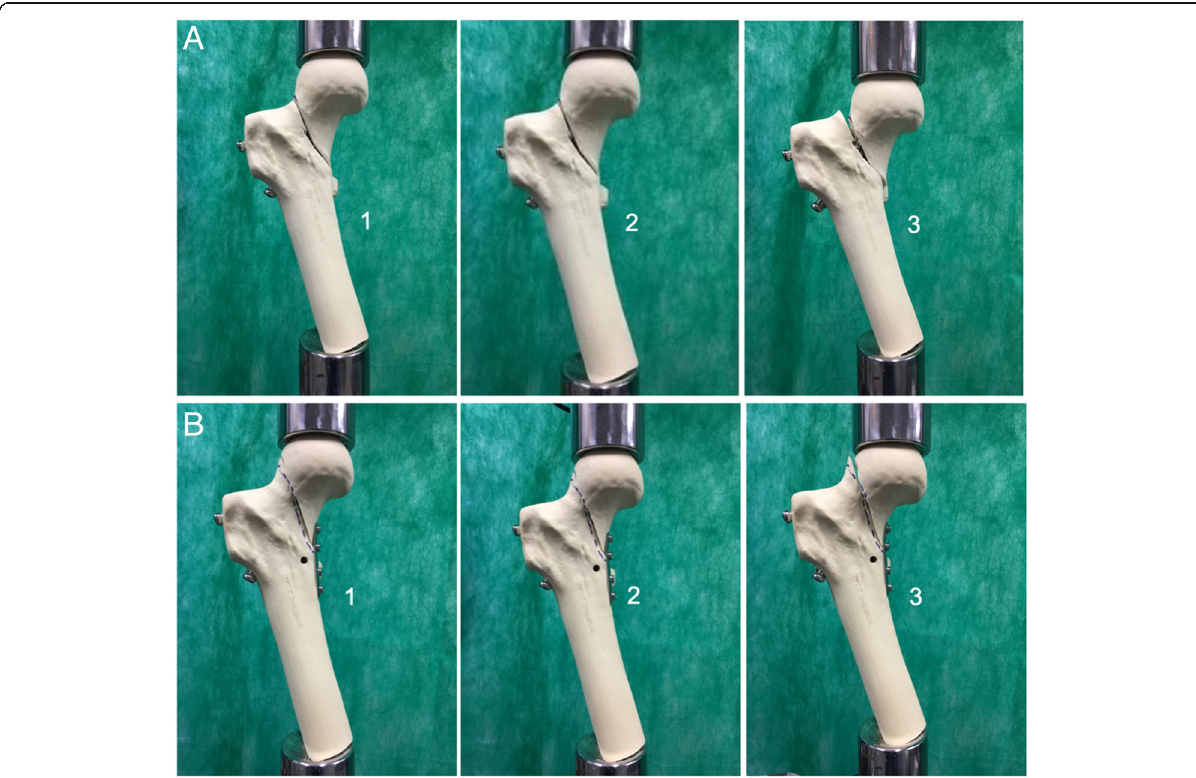
Fig. 3 a . Group 1 specimen with two parallel cannulated screws in the lower portion of the femoral neck + Pauwels screw, anterior view: (1) prior to testing, (2), after step 1, and (3) after failure in step 2. Note that there was virtually no change after step 1, but step 2 led to varus deviation and shearing of the femoral neck. Note the protrusion of the fixation screws, particularly the inferior screws; b . Group 2 specimen with two parallel cannulated screws in the lower portion of the femoral neck + Pauwels screw + medial plate, anterior view: (1) prior to testing, (2) after step 1, and (3) after failure in step 2. Mild rotational deviation occurred in four of the five specimens after step 1. In step 2, a slight diastasis was observed in the superior region of the femoral neck, but no varus deviation or shearing occurred. Note that the inferior fixation screws protruded less after testing than those in the G1 specimens